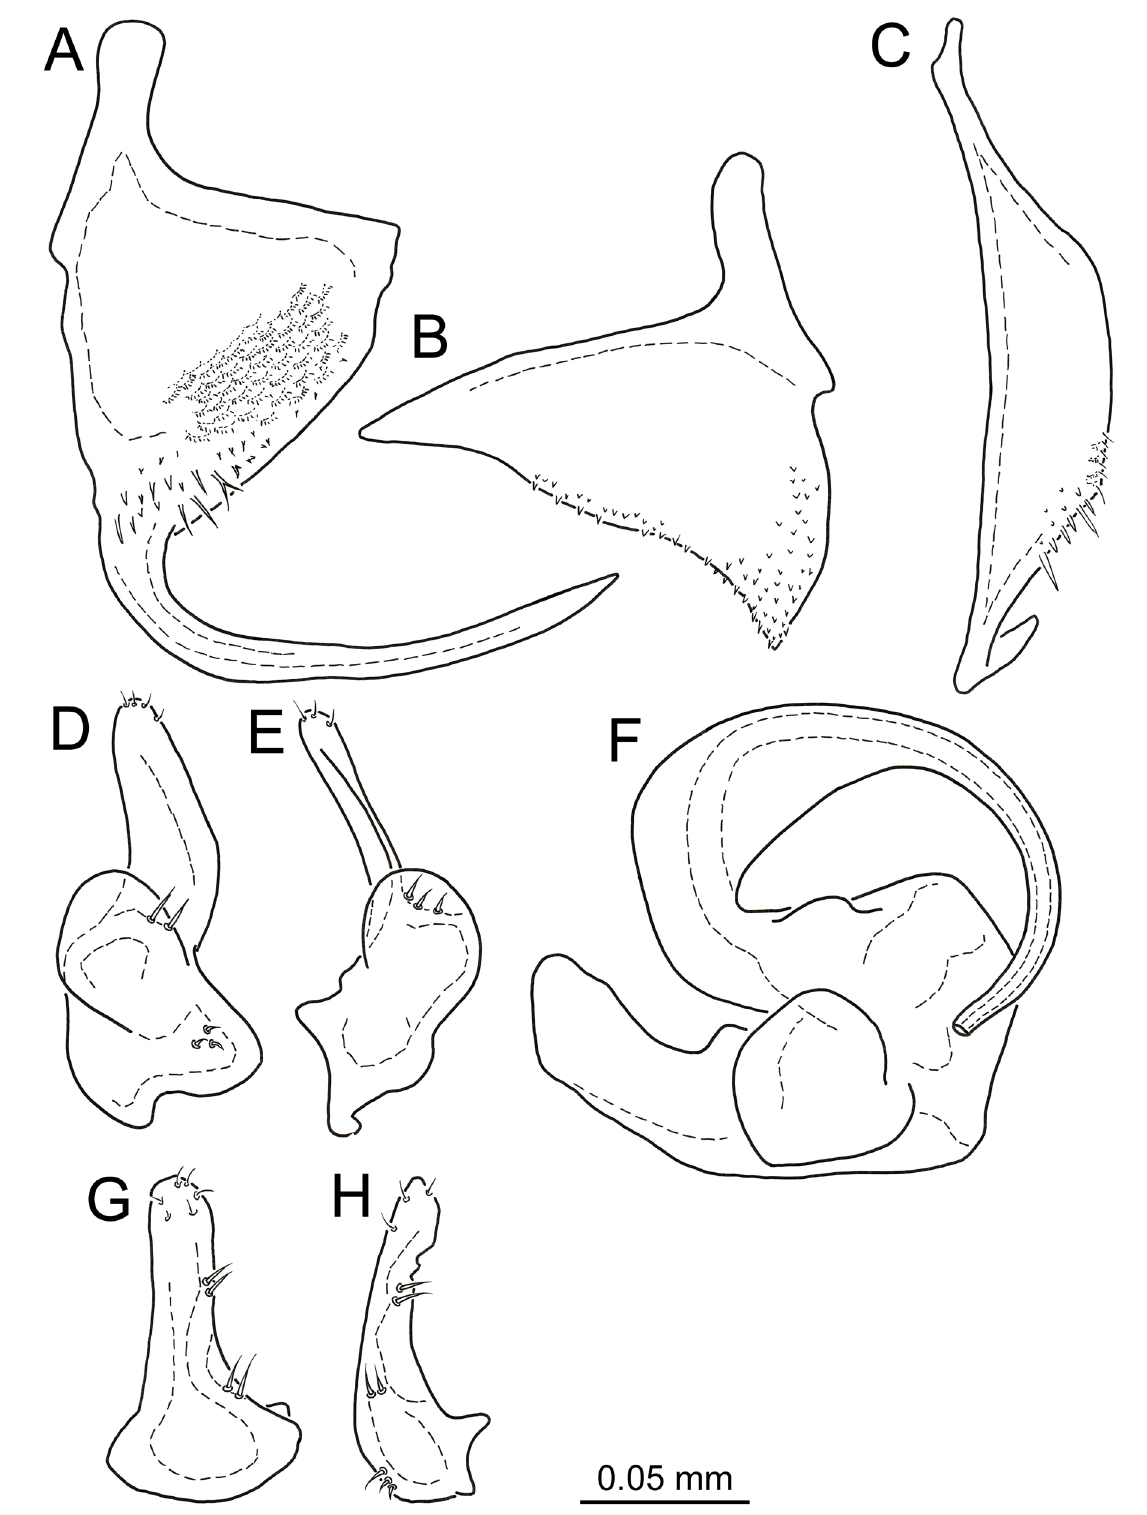
Fig. 18. Kokeshia redeii sp. nov., segment VIII and genitalia, paratype, ♂ (SYSBM). A, C . Left hemitergite VIII. A . Dorsal view. C . Left lateral view. B . Right hemitergite VIII, dorsal view. D‒E . Left paramere, two different aspects. F . Phallus. G‒H . Right paramere, two different